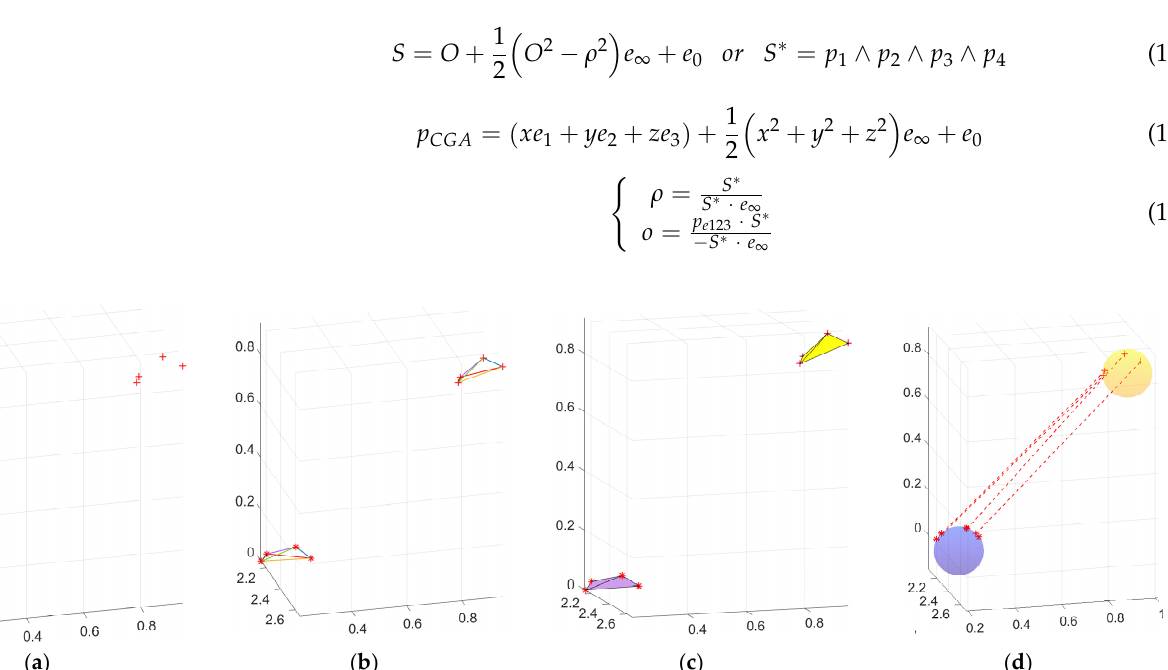
Figure 4. Rotation-invariant features of the four geometries. ( a ) * means the reference point cloud, and + means the target point cloud. ( b ) Line segment composed of any two points p 1 ∧ p 2 ∧ e ∞ . ( c ) Plane composed of any three points p 1 ∧ p 2 ∧ p 3 ∧ e ∞ . ( d ) Circumscribed sphere p 1 ∧ p 2 ∧ p 3 ∧ p 4 made up of four